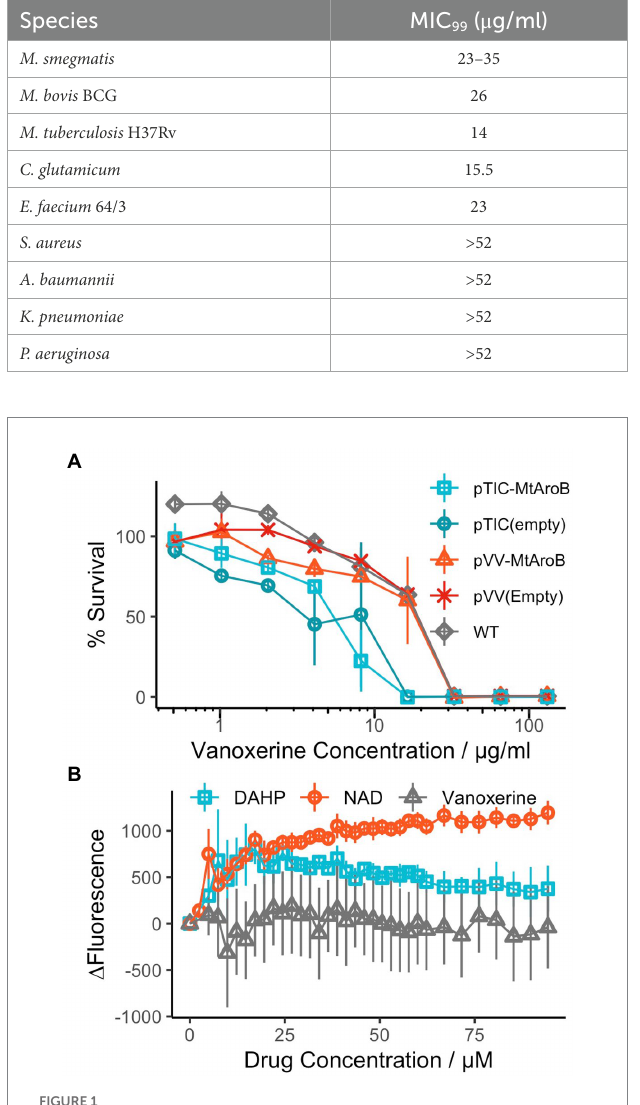
FIGURE 1 AroB overexpression had no effect on vanoxerine killing and vanoxerine does not bind to the purified protein. (A) % Survival Curve of M. smegmatis over-expressing M. tuberculosis AroB relative to empty vector controls, against vanoxerine. All M. smegmatis strains were grown in the presence of vanoxerine, with resazurin used to quantify survival. The % survival was calculated compared to DMSO and rifampicin controls. N = 3. (B) Fluorimetry using the tryptophan fluorescence of purified M. tuberculosis AroB protein titrated against vanoxerine and known binding compounds. The change in fluorescence ( ∆ Fluorescence) was calculated compared to the baseline fluorescence, following each drug addition, with the changes due to solvent (buffer or 10% DMSO) subtracted. DAHP (substrate) = 3-deoxy-D-arabinoheptulosonate 7-phosphate, NAD (co- factor) = nicotinamide adenine dinucleotide. N =